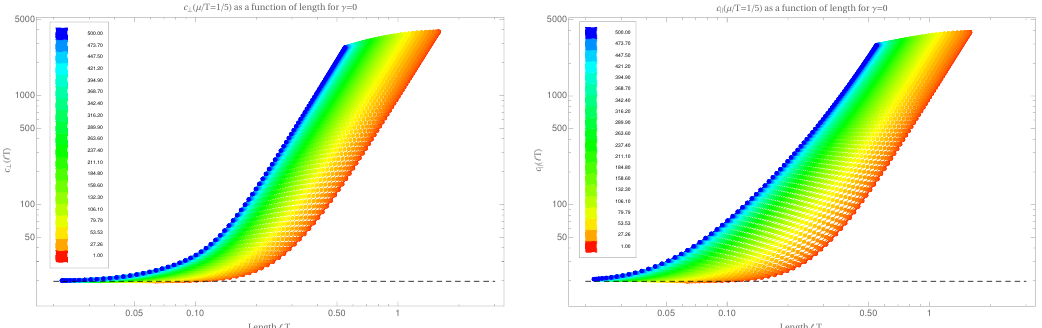
Figure 15 . We display the c-functions at γ = 0 computed in two ways, firstly via direct numerical calculation utilizing eq. (4.18) and eq. (4.19) (lines), and secondly via the conserved charge as given in eq. (4.37) and eq. (4.38) (dots). Left: ∆ c ⊥ , Right: ∆ c . In both graphs these are displayed as || a function of dimensionless length ‘T at fixed µ/T = 1 / 5 for B/T 2 varying from B/T 2 = 1 . 00 to B/T 2 = 500 . 00 . The dashed line displays the UV value of the central charge a 4 = 2 π 2